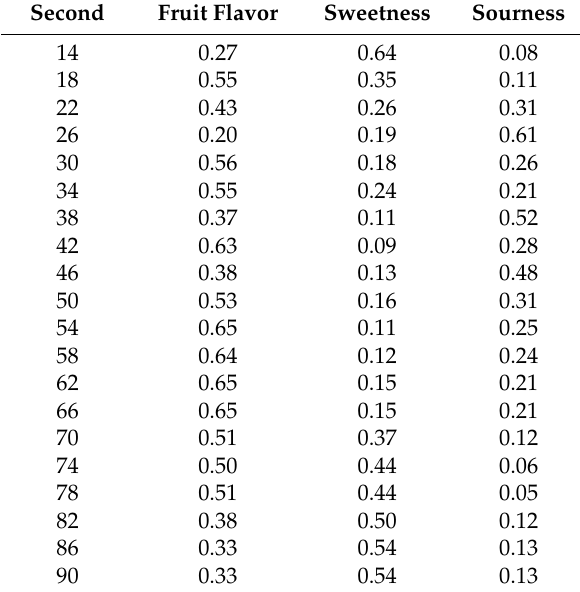
Table 4. LMG values for each consumer just-about-right attribute to Overall Liking of Flavor (Sample B) varying with time